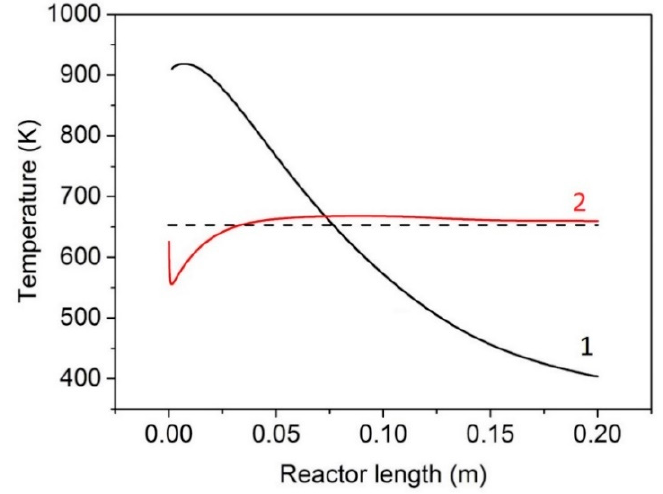
Figure 3. Optimised temperature profiles in the MRHE at counter-current (1) and co-current (2) operation. Reactant flow rate: 2.71 × 10 − 2 m s − 1 . Coolant flow rate: 0.18 m s − 1 . Reactant inlet tempera- ture: 473 K. Coolant inlet temperature: 498 K. Plate thickness, a = 1.5 mm. These data are in line with the methanol concentration profile and the related heat generation curve. At the isothermal operation at 653 K (shown as dashed line in Figure 3), half of the reaction heat is released in the area of 0–40 mm and the other half is spread out through the remaining 160 mm length (Figure 4a). The respective concentration profiles are shown in Figure 4b.